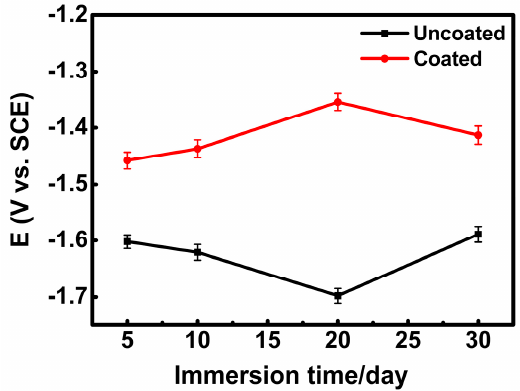
Figure 11. The evolution of open circuit potentials for the uncoated and the coated samples after immersion for 30